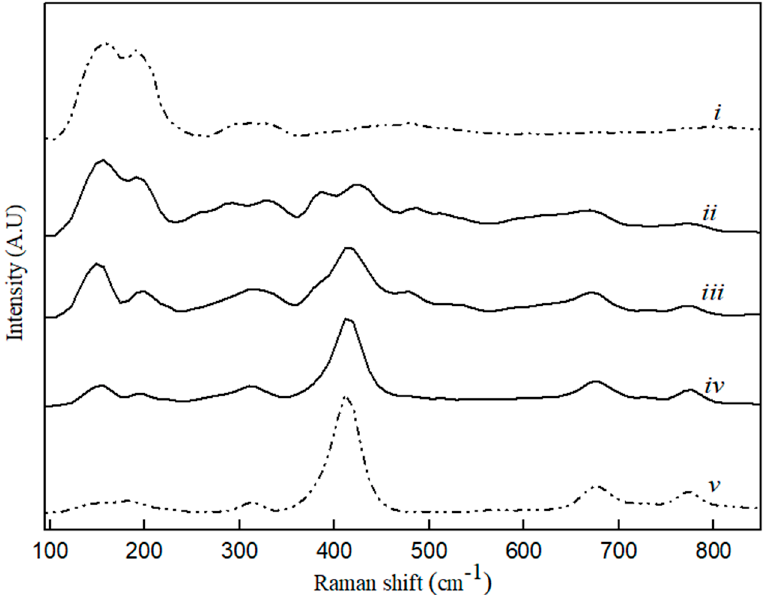
Figure 4. Raman spectra for CaS ( i ), MA ( v ) and binary MA–CaS phase sample with CaS content, where ( ii ) 80 wt. %, ( iii ) 60 wt. %, and ( iv ) 20 wt. %.